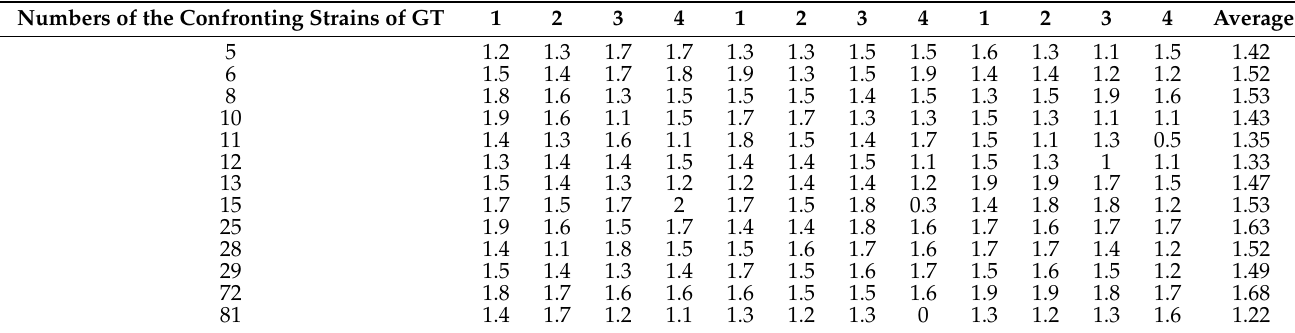
Table A2. Diameter of the inhibition zone of the strains against Gloeophyllum trabeum. The data in one row are three sets of replicates of the same